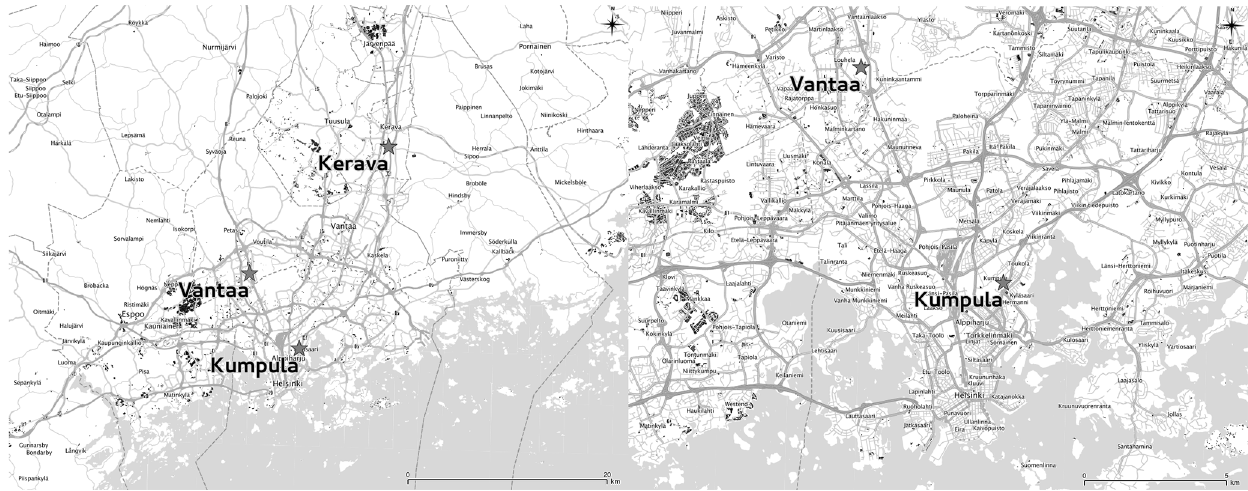
Figure 1. The weather radar locations within the metropolitan area of Helsinki, Finland. Left: the map overview of the three radar sites. Right: the detailed map for Vantaa and Kumpula radar indicating main roads, railways and